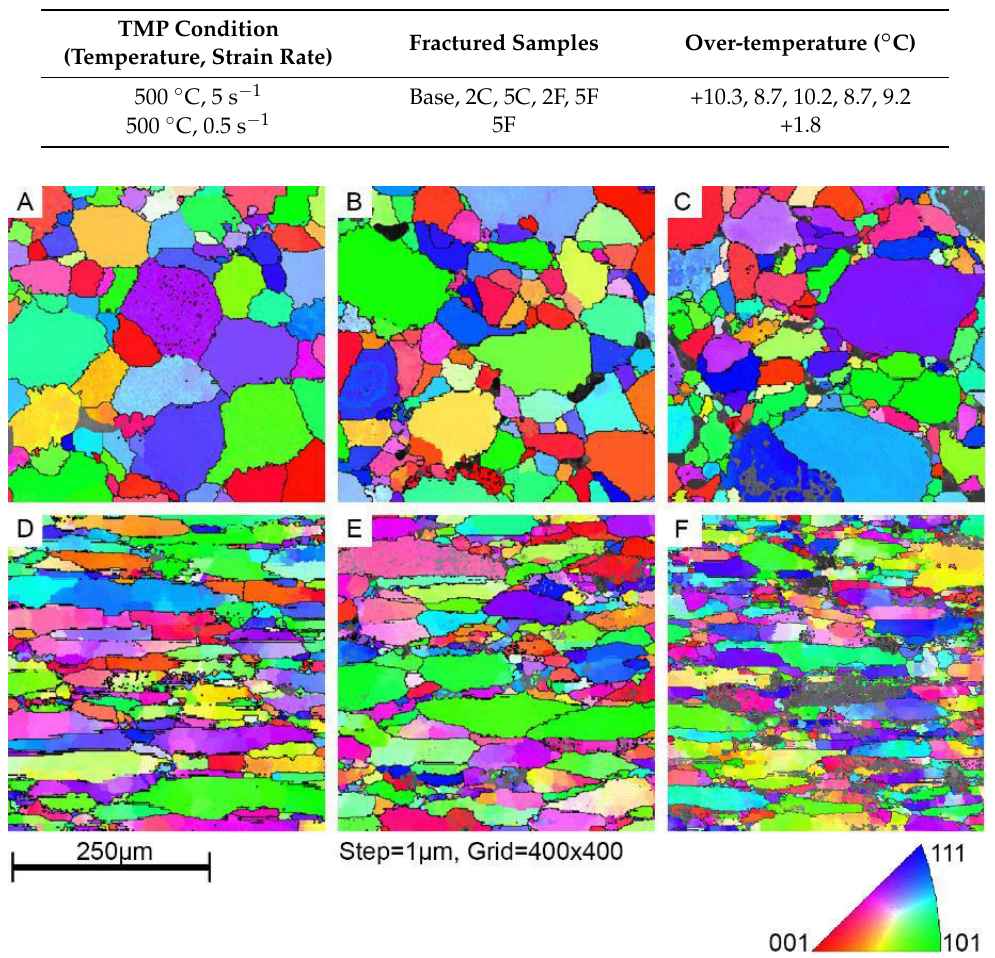
Figure 4. EBSD map of ( A ) Base, ( B ) 2C, and ( C ) 5C in the as sintered condition as well as variants deformed at 500 °C and 0.005 s −1 for ( D ) Base, ( E ) 2C, and ( F ) 5C. TMP direction vertical with respect to page orientation.